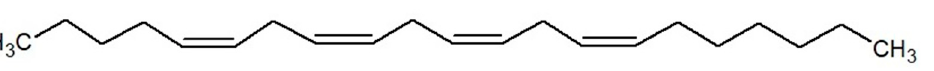
Figure 3. Mean percentage (%) mass eaten of mineralized (MIN) and demineralized (DEM) tissues of P. gymnospora and control (CTRL— U. fasciata ) by L. variegatus . Different letters indicate distinct consumption ( p < 0.05). Values are means and standard deviation of n = 10.